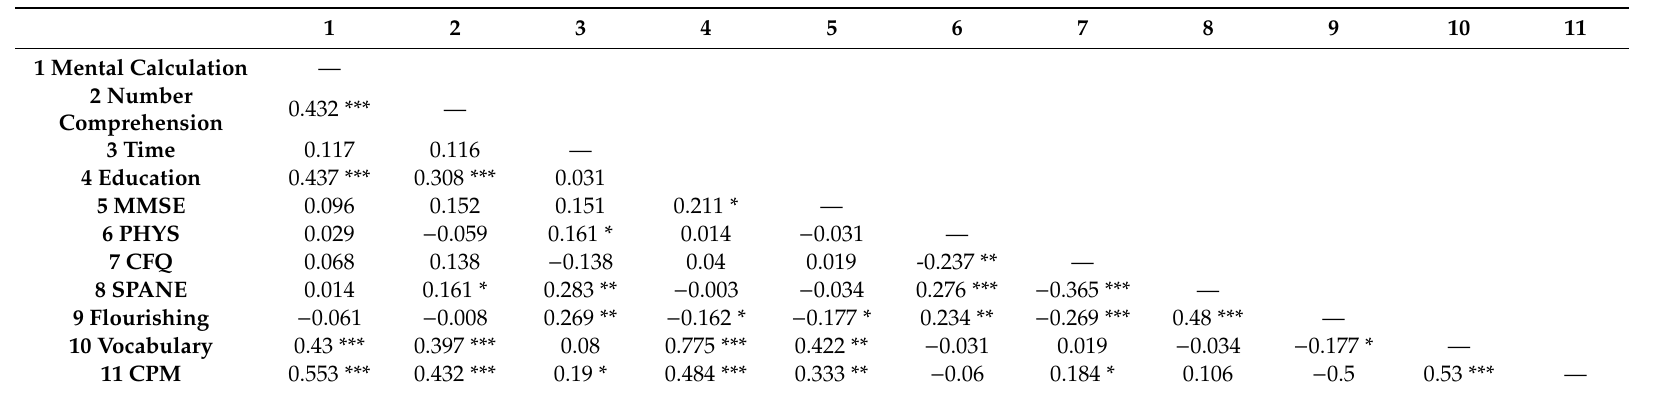
Table 2. Person’s correlations among numeracy (i.e., Mental Calculation, Number Comprehension), time spent for leisure activities (i.e., Time), years of education (i.e., Education), global cognitive e ffi ciency (i.e., MMSE), perceived physical health (i.e., Perceived Physical Health index (PHYS)), metacognitive e ffi ciency (i.e.,